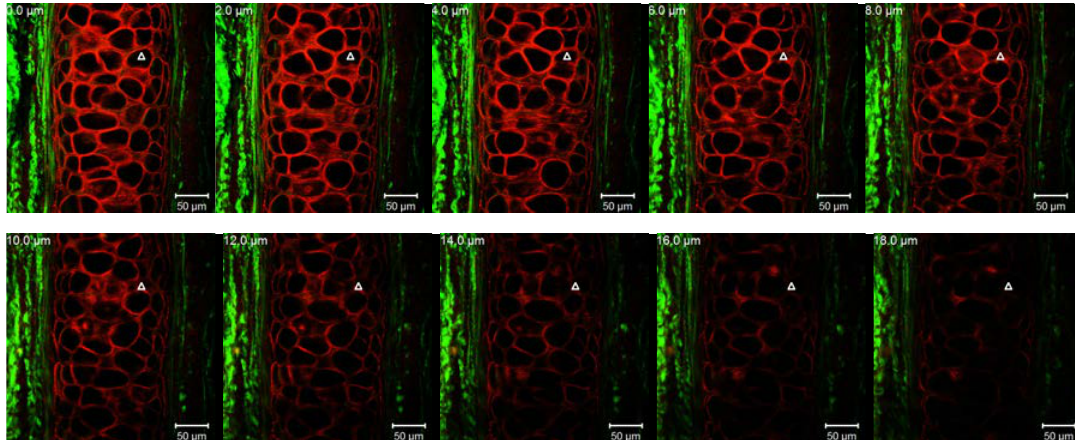
Fig. 2. A total of 10 sequential SHG/TPEF overlapping images at intervals of 2 (cid:1) m, providing the 3D shape of chondrocytes and the morphology of the surrounding collagen and elastic ¯bers. The triangle points to a chondrocyte to visualize the shape varied with depth. Scale bar ¼ 50 (cid:1)